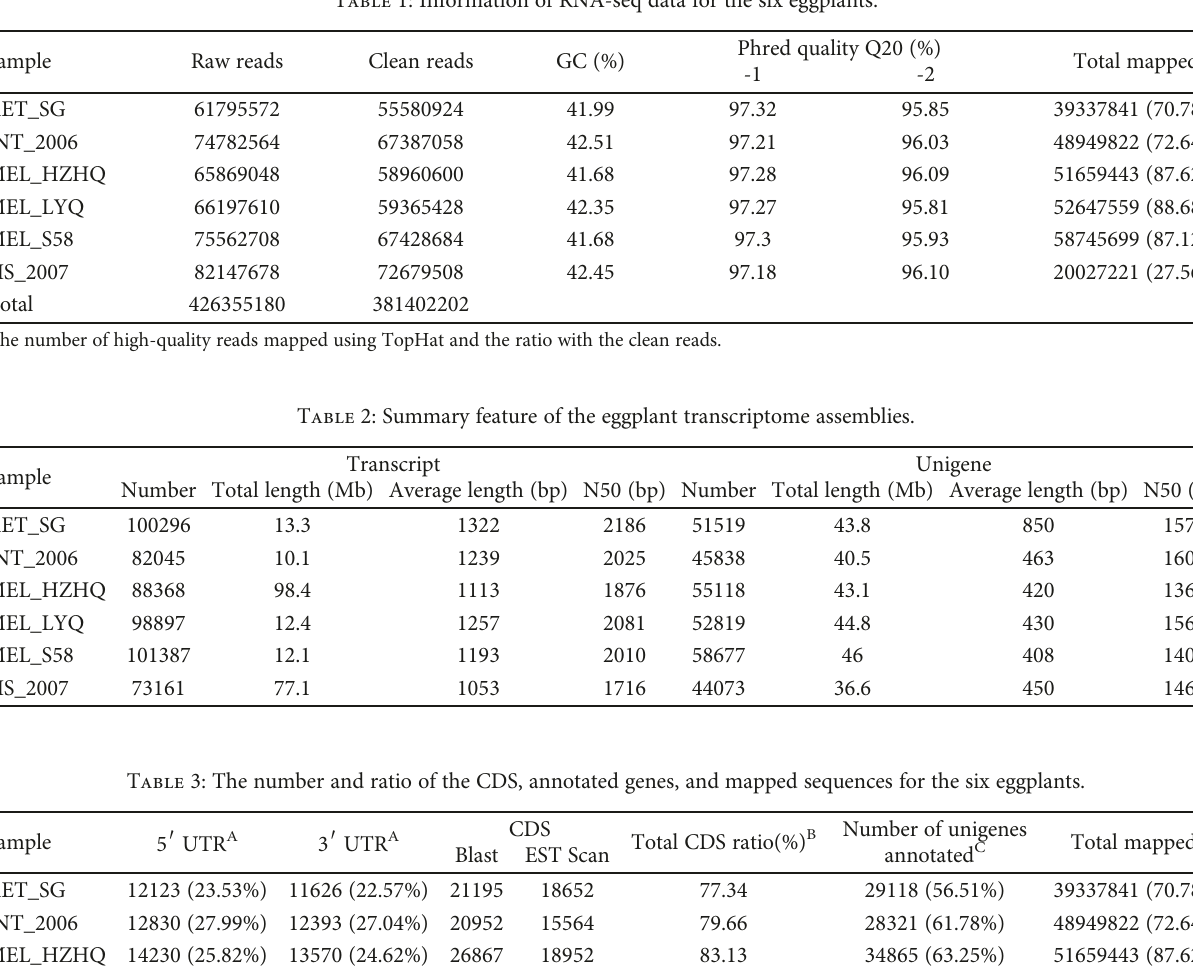
Table 1: Information of RNA-seq data for the six eggplants.